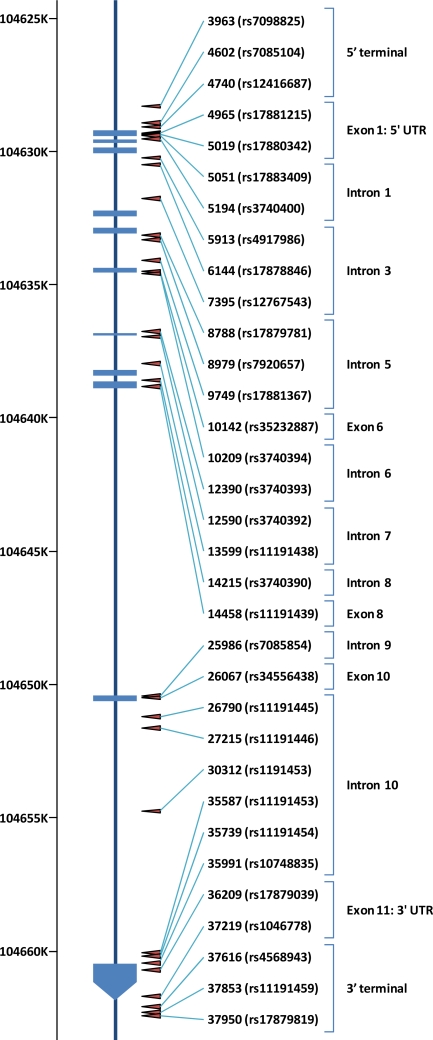
Location of genetic polymorphisms in AS3MT. Dark blue rectangles represent exons. Chromosome positions are also indicated. Arrows show the locations of genetic polymorphisms.